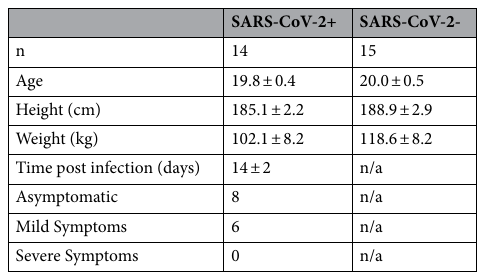
Table 1. Participant’s physical characteristics (mean ±